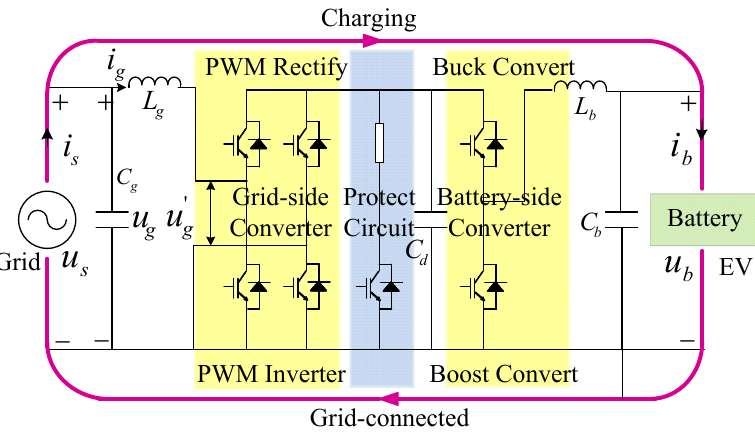
Figure 2. The proposed bi-directional transfer circuit topology for